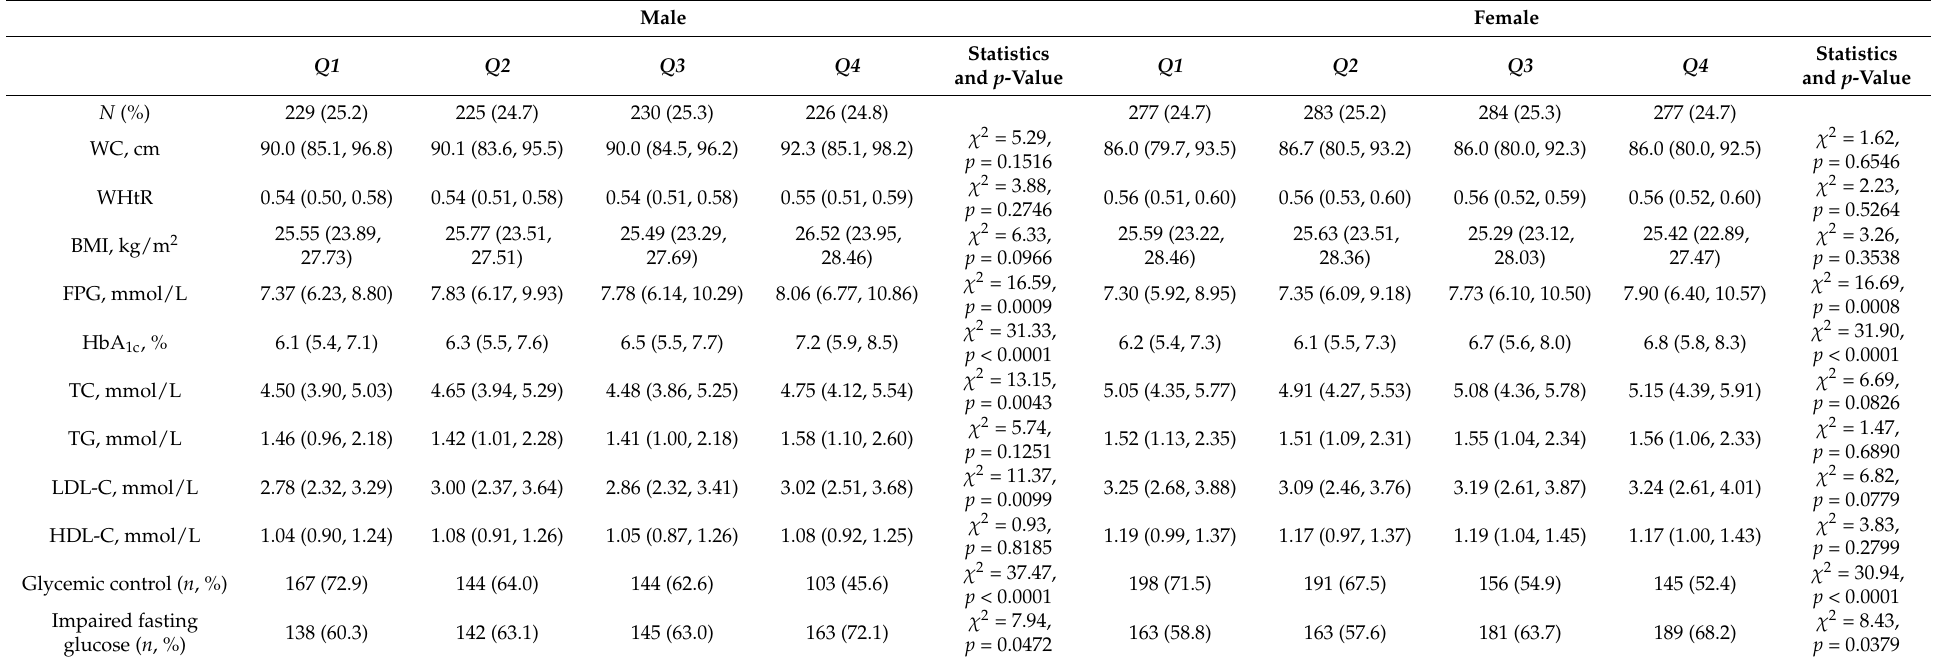
Table 7. Clinical and anthropometric indicators of participants according to the quartile of dietary pattern scores ( M ( P 25 , P 75